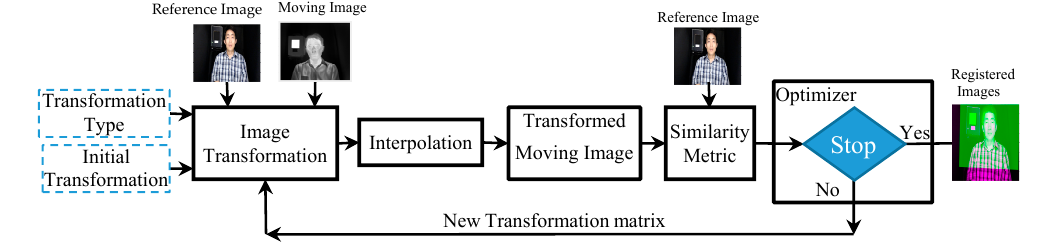
Figure 3. Block diagram of image registration.